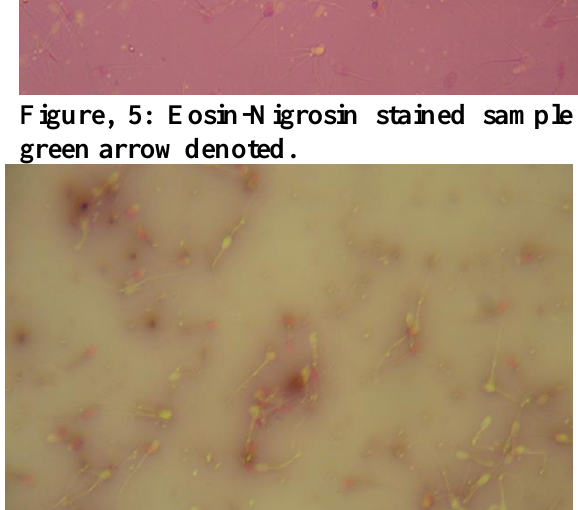
Figure, 6: Out of season sperm sample after capacitation with limited sperms